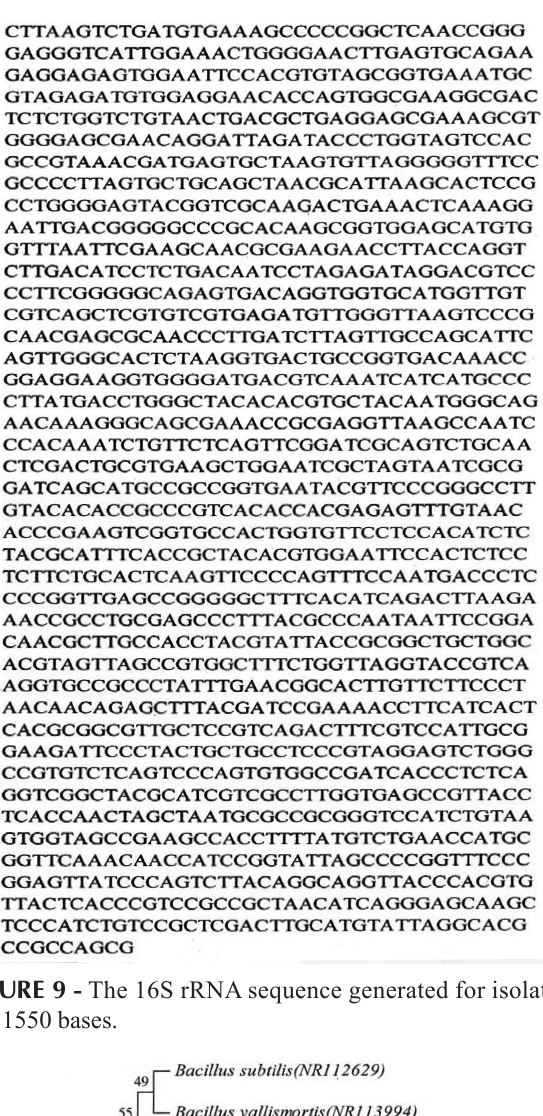
TABLE II - Microbial isolates from non-parenterals identified by